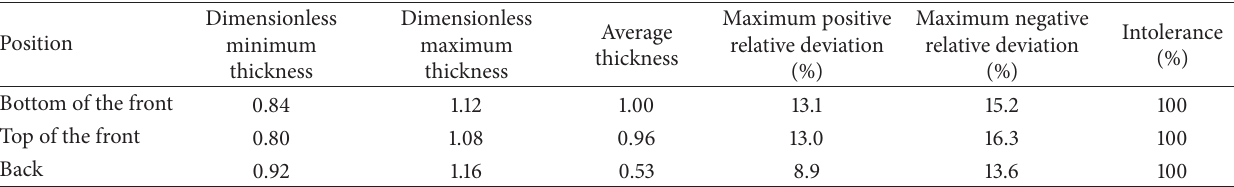
Table 1: Dimensionless thickness on different